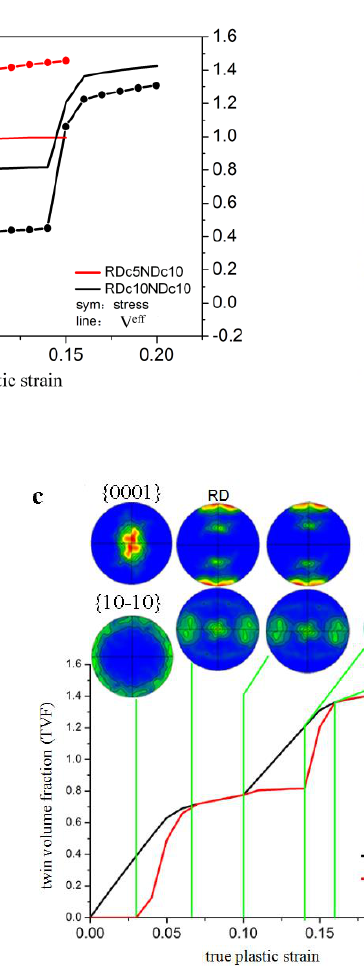
Fig. 6 . (a) Flow stress (symbols) combined with effective twin volume fraction (line); texture evolution combined with accumulated and effective twin volume fractions for (b) RDc5-NDC and (c)